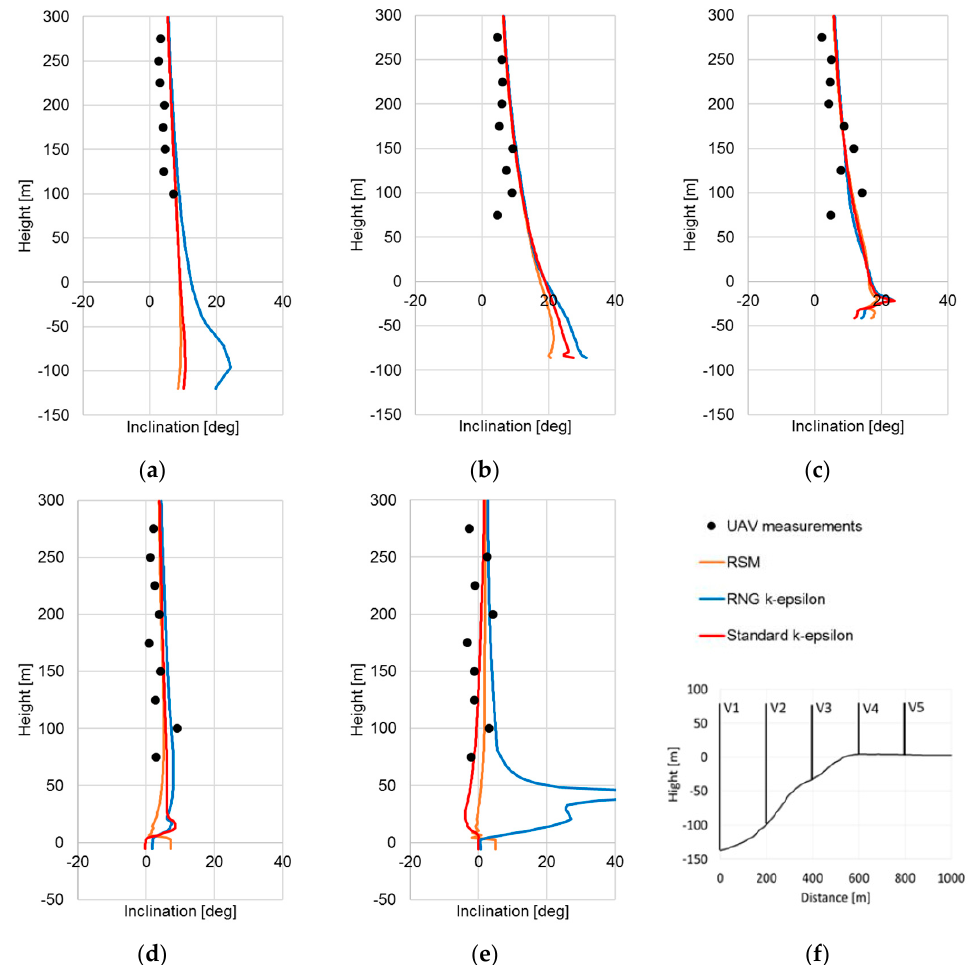
Figure 11. ( a ) Inclination position V1; ( b ) inclination position V2; ( c ) inclination position V3; ( d ) inclination position V4; ( e ) inclination position V5; ( f ) legend and location of measuring positions.